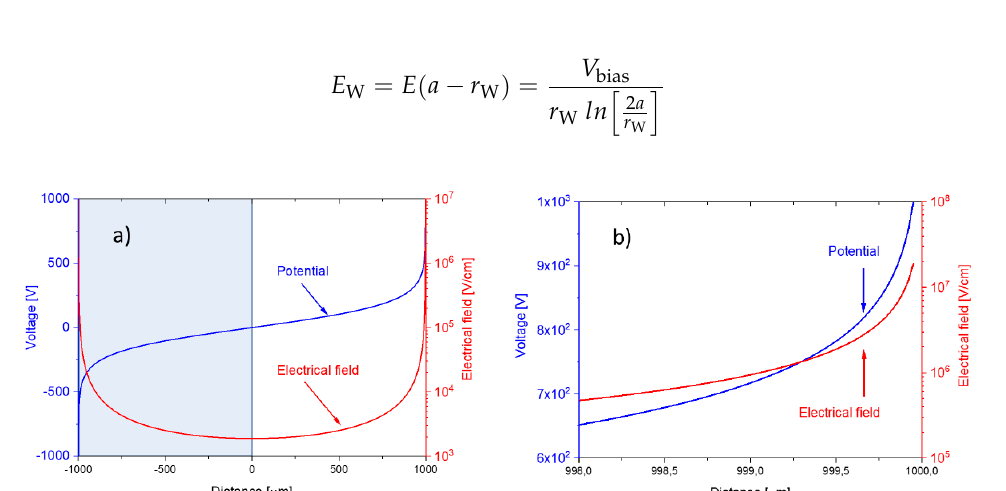
Figure 14. ( a ) Potential (blue) and electrical field distribution (red) inside the air gap separating a pair of parallel nanowires. The right-hand part of both distributions ( x > 0) represents the potential and electrical field distributions of a positively charged nanowire facing a conducting flat-plate collector electrode placed in the plane, x = 0; ( b ) potential and electrical field distributions close to the nanowire surface.